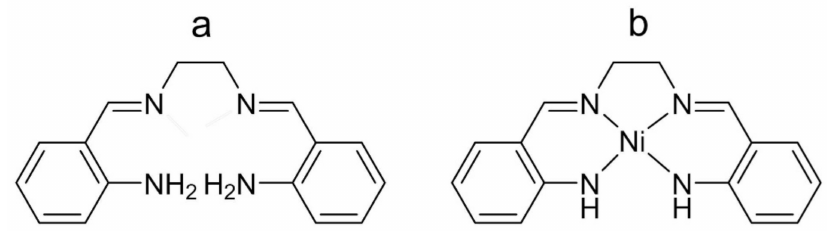
Figure 1. Molecular structures of ( a ) H 2 Amben, and ( b ) its nickel(II) complex